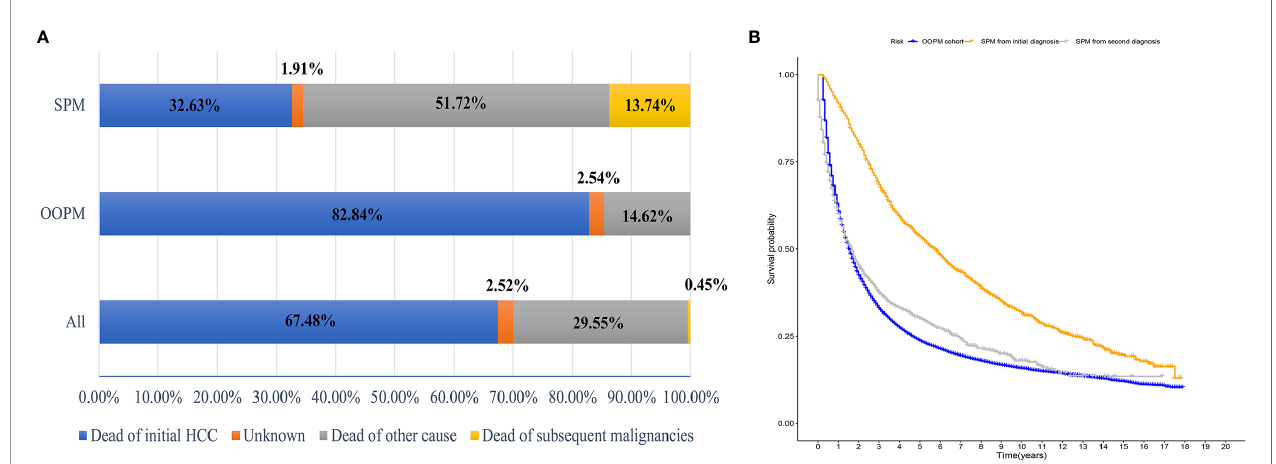
FIGURE 1 | Distribution of the causes of death and estimates of overall survival for HCC patients. (A) Distribution of the causes of death for all HCC patients and for patients in the OOPM and SPM groups. (B) Estimates of overall survival for HCC patients in the OOPM group, for patients in the SPM group from their initial diagnosis and from their second diagnosis. HCC, hepatocellular carcinoma; OOPM, only one primary malignancy; SPM, second primary